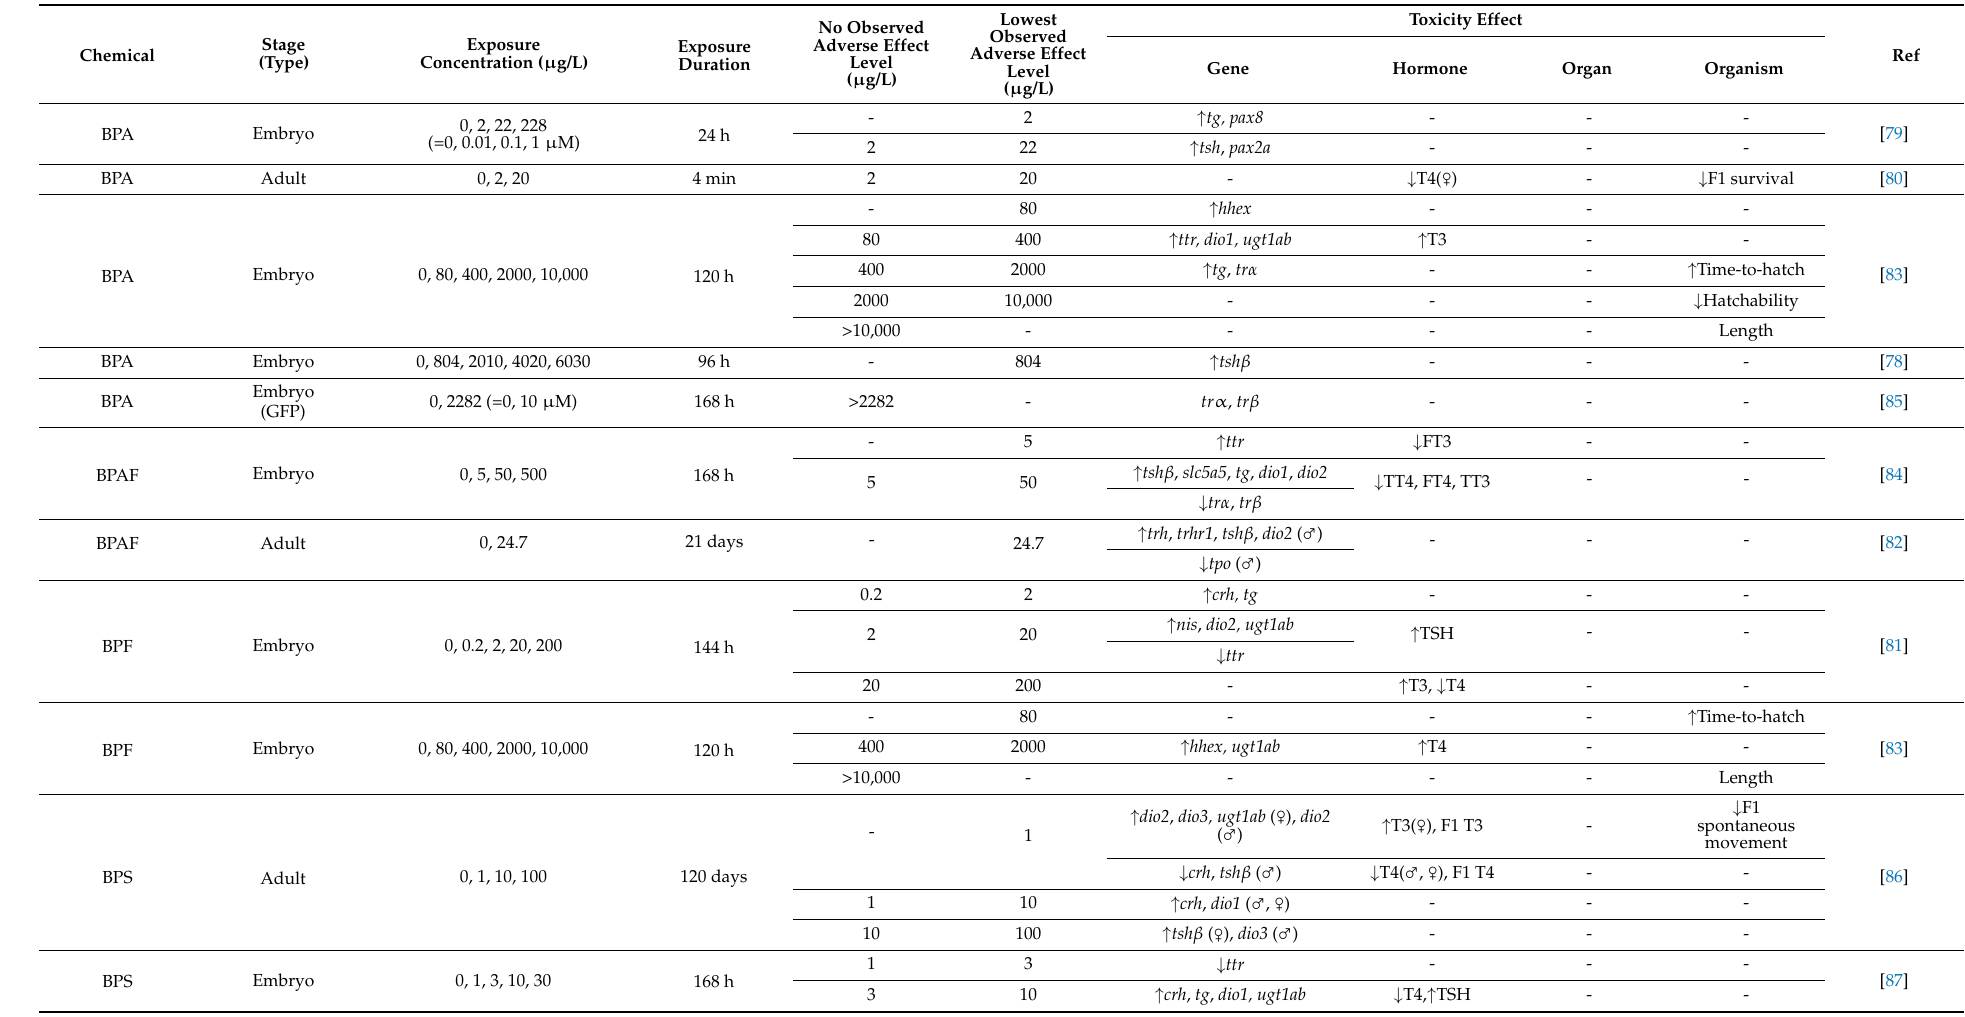
Table 4. Summary of studies about hypothalamic-pituitary-thyroid (HPT) axis in zebrafish exposed to bisphenol A and its